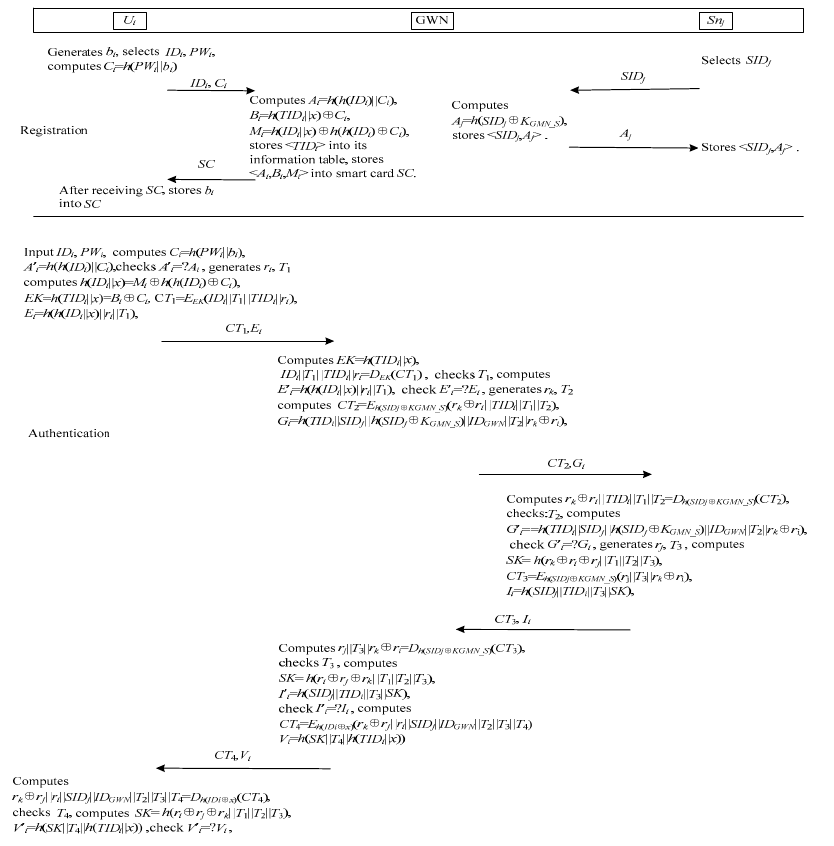
Figure 2. The authentication and key agreement phase of Lu et al.’s scheme.